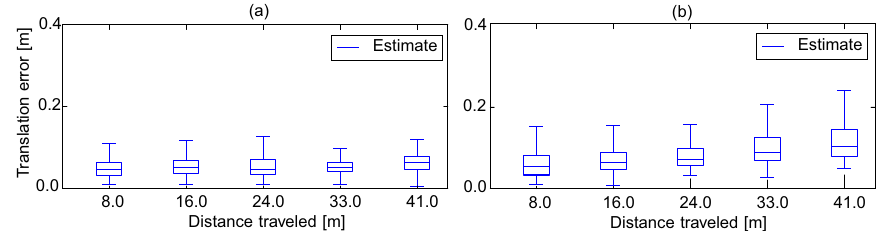
Figure 9. The comparison of the relative translation error of Basalt and our method on sequence V2_02. ( a ) The relative translation error of our proposed method and ( b ) the relative translation error of